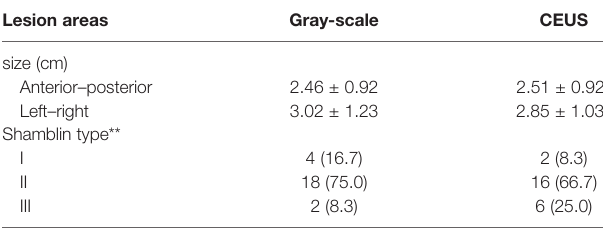
TABLE 2 | Morphology of CBT lesions (n = 24).